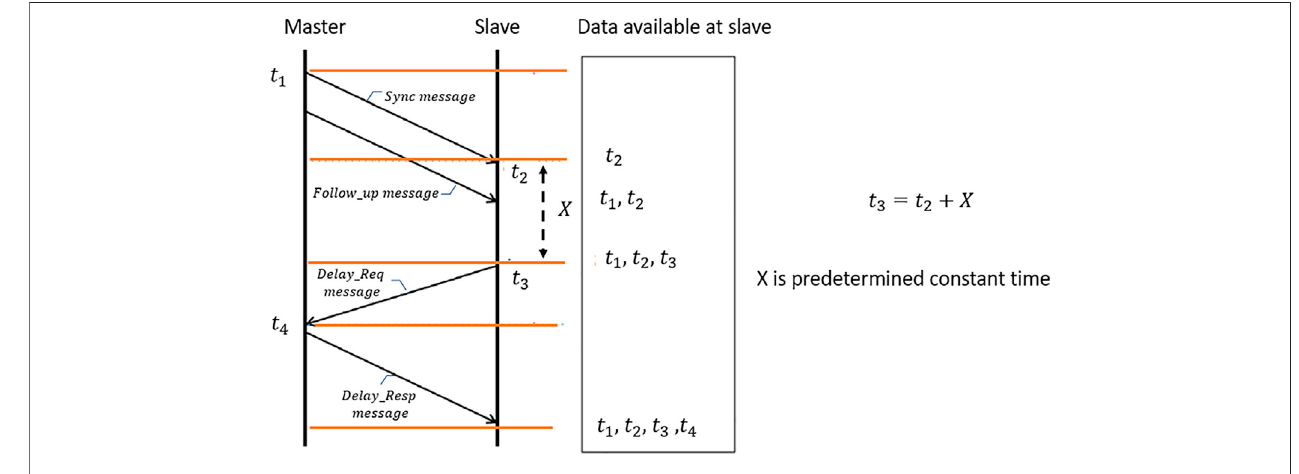
FIGURE 1 | PTP messaging timing